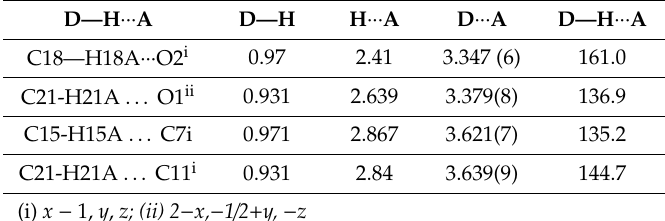
Figure 2. The intermolecular C-H... π (magenta) and O...H (red) contacts in the crystal structure of 3 .